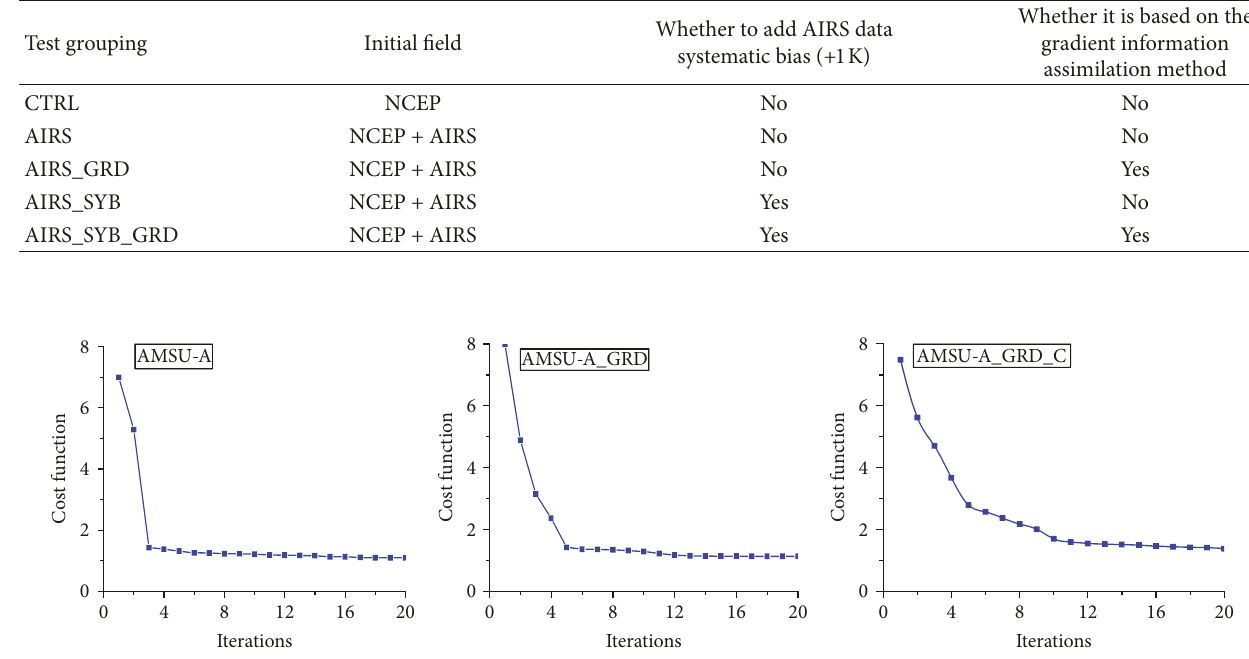
Table 2: Schemes of numerical test.